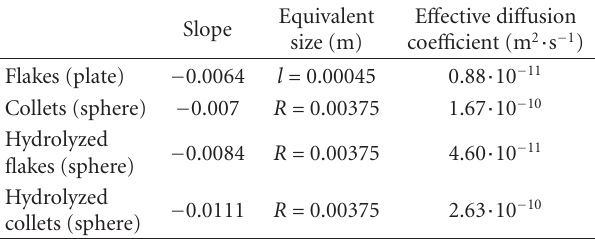
Table 5: Estimated e ff ective di ff usion coe ffi cients at 25 ◦ C.